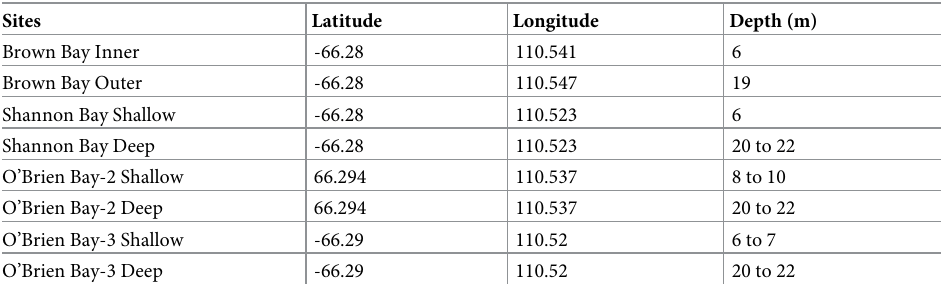
Table 2. Depth and coordinates of the sites.